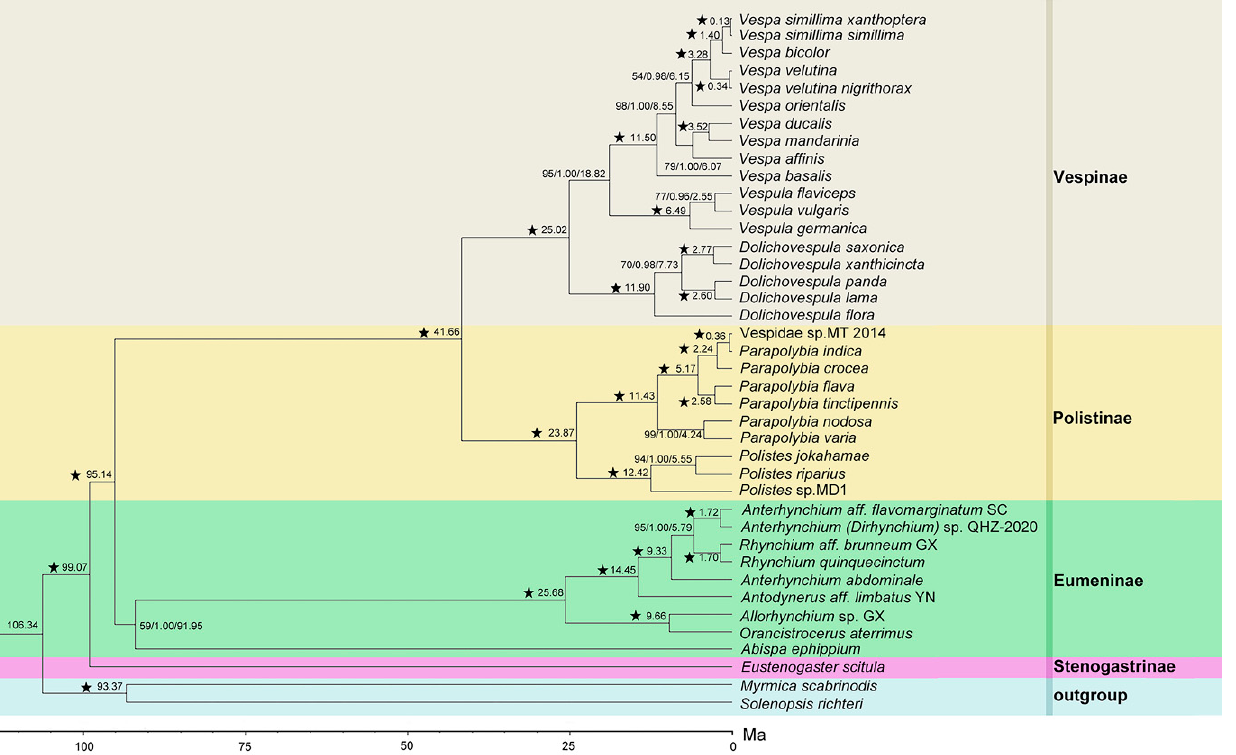
Figure 3. Phylogenetic tree of Vespidae based on the PCG123R dataset by Bayesian inference (BI) and Maximum-Likelihood (ML) methods with evolutionary time scale using beast analysis. Values above the nodes represent divergence time/Bayesian posterior probabilities/ML bootstrap values, respectively. “ ★ ” indicates Bayesian posterior probabilities = 1.00 and ML bootstrap = 100. A time scale is shown at the bottom. Ma = one million years ago.